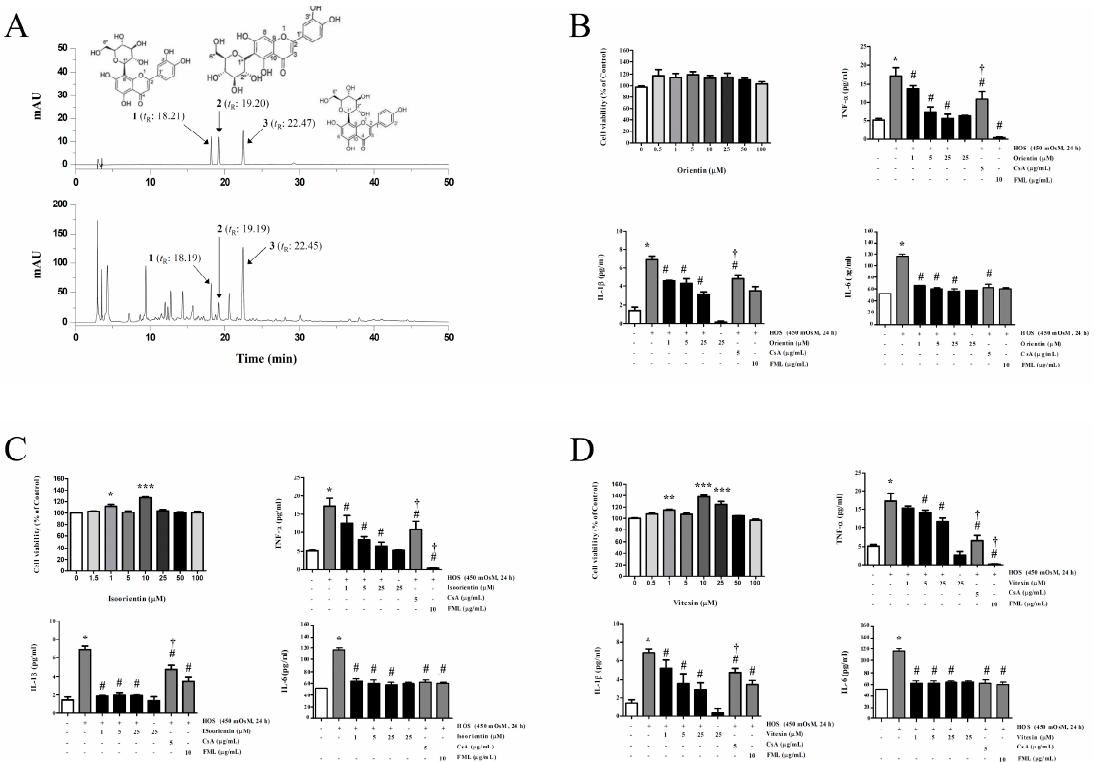
Figure 7. High- performance liquid chromatography with diode array detection (HPLC-DAD) chromatograms of three compounds in KIOM-2015EW and the anti-inflammatory effect on proinflammatory cytokines (TNF-a, IL-1 β and IL-6) in HOS-induced HCECs. Orientin (1); isoorientin (2); vitexin (3) in standard mixture and KIOM-2015EW ( A ) were identified at wavelengths of 280 nm. HCECs were cultured in isomer (312 mOsM) medium, switched to hyperosmotic medium (450 mOsM) alone or in the presence of different concentrations of orientin ( B ), isoorientin ( C ) and vitexin ( D ) for 24 h. cell viability measured by CCK-8 assay and protein levels were estimated by enzyme-linked immunosorbent assay (ELISA). CsA and FML were used as positive anti-inflammatory drugs. Data are summarized as mean ± SD from three independent experiments. HOS, hyperosmolar stress; CsA, cyclosporine A; FML, fluoremetholone. * p < 0.05 vs. control, # p < 0.05 vs. HOS, † p < 0.05 vs. KIOM-2015EW (25 μ g/mL).